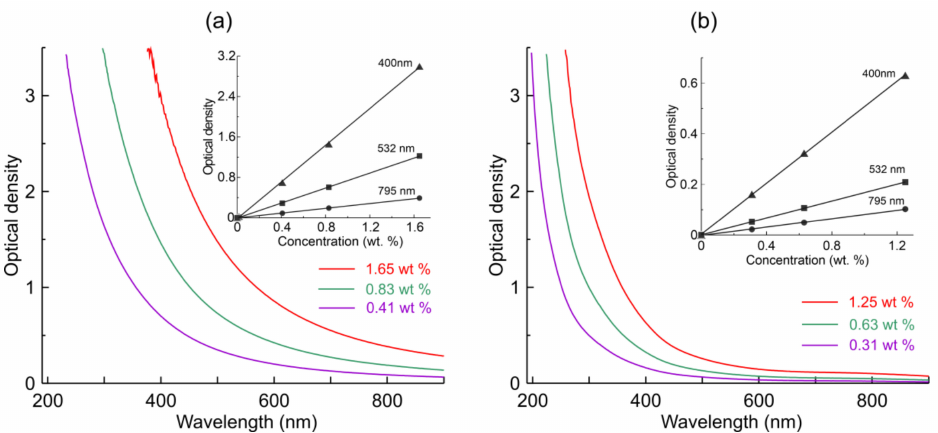
Figure 3. The optical density of the ( a ) HP-HT and ( b ) detonation nanodiamond suspensions in 1 mm thick quartz cell. Insets show the corresponding optical density as a function of concentration measured at three different wavelengths of 400, 532, and 795